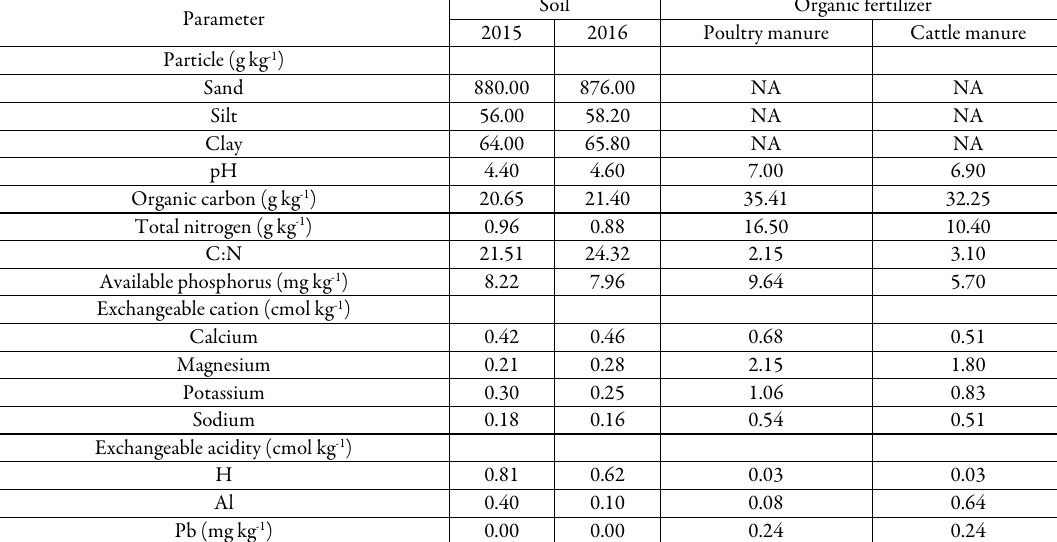
Table 1. Physical and chemical properties of the experimental site before cropping with maize and chemical composition of organic fertilizers Parameter